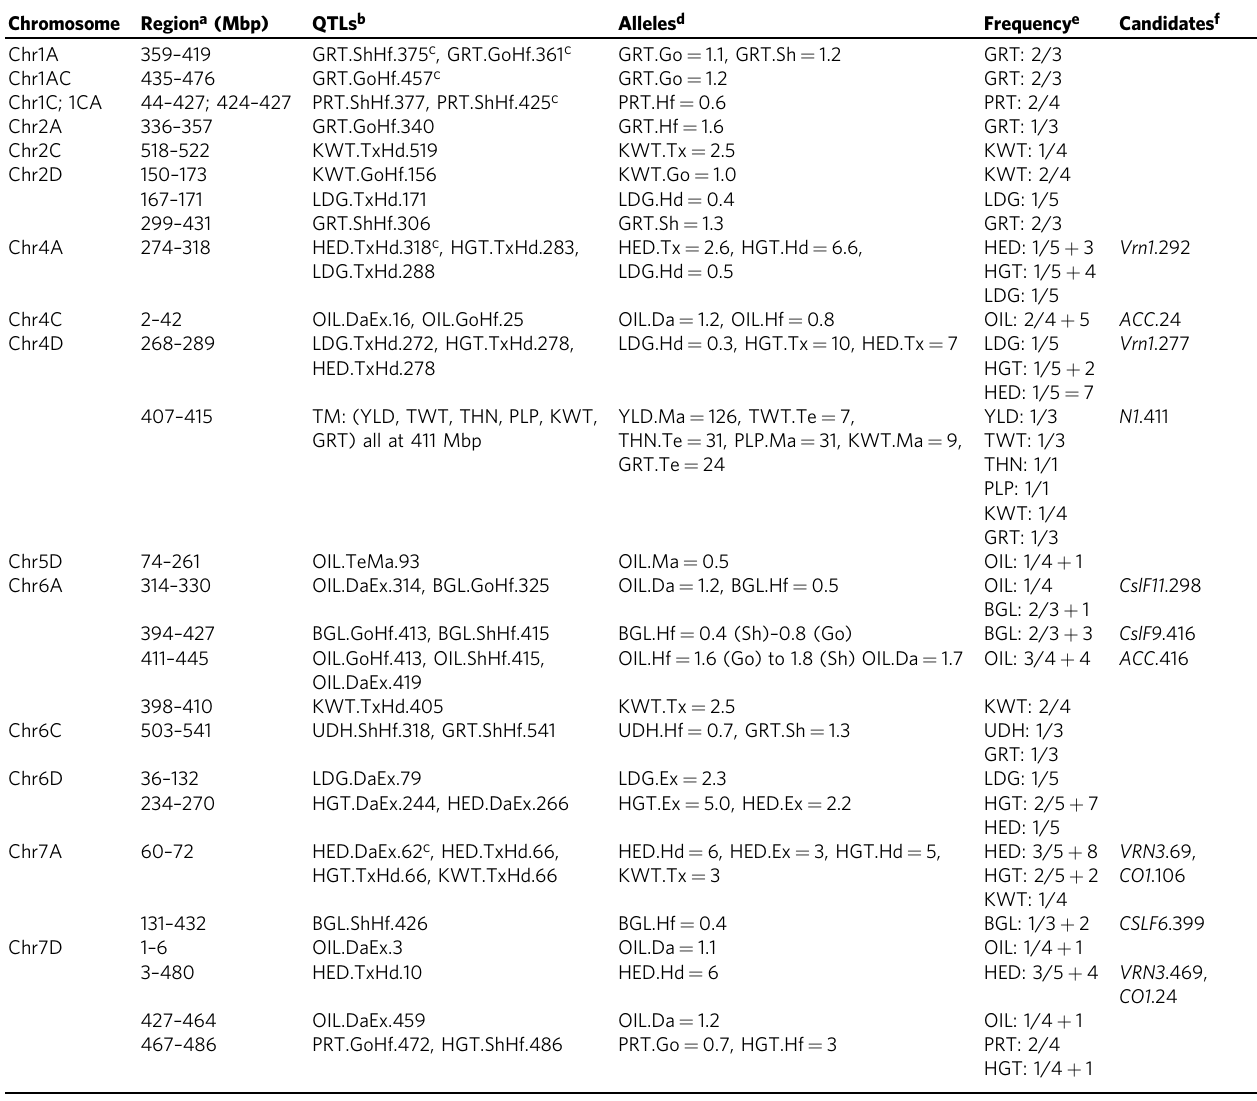
Table 1 Regions of the oat genome containing major QTLs and/or candidate genes. Chromosome Region a